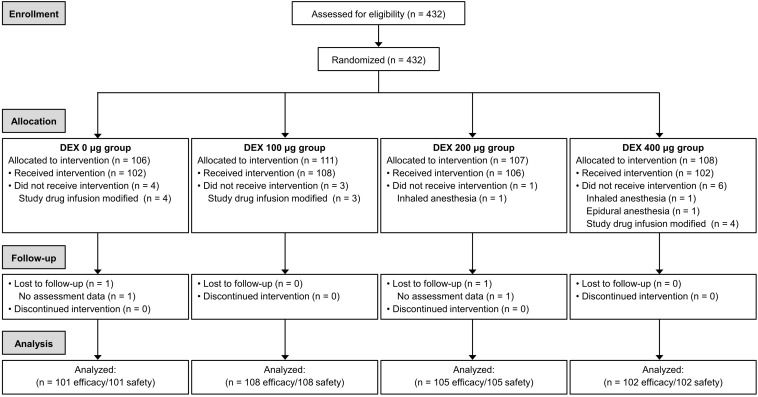
CONSOR diagram. DEX, dexmedetomidine.